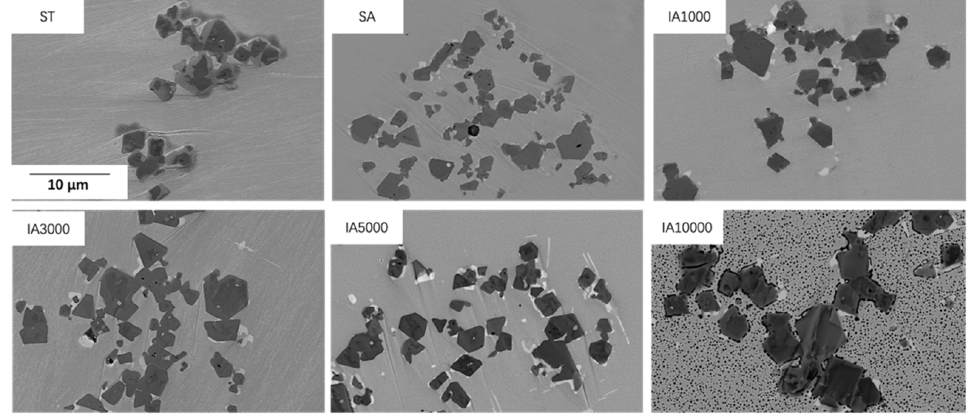
Figure 6. Micrographs of MX in different heat-treated samples.